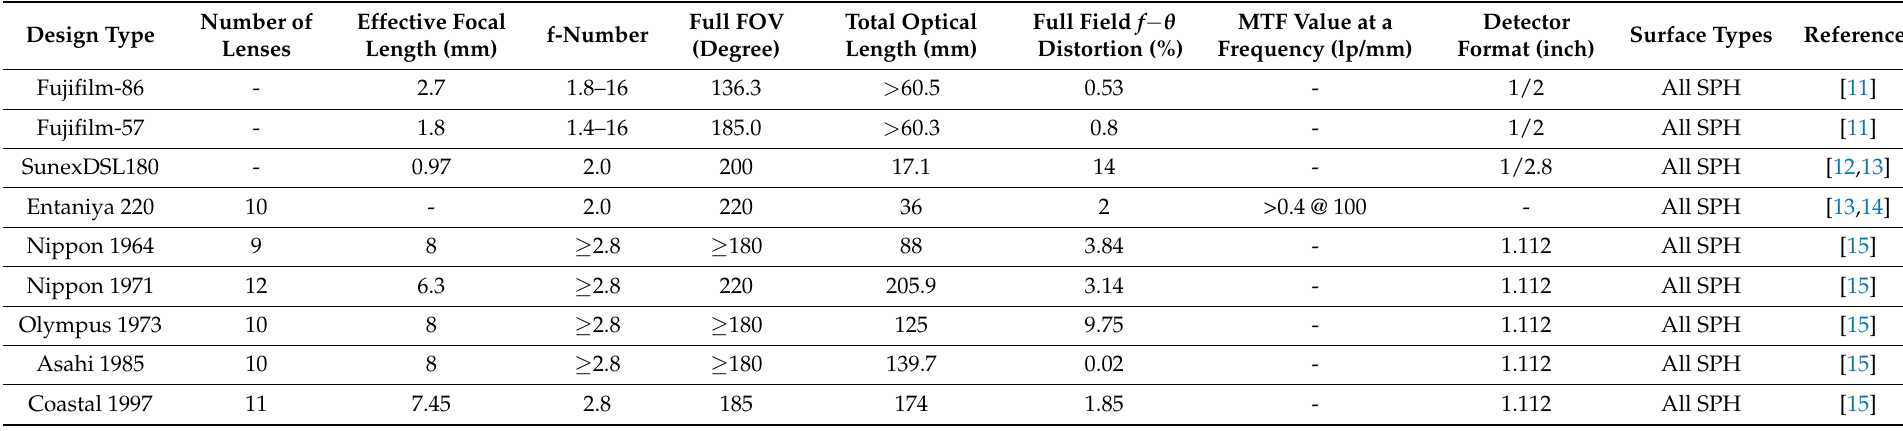
Table 1. State-of-the-art COTS WFOV visible and near-infrared imaging designs.